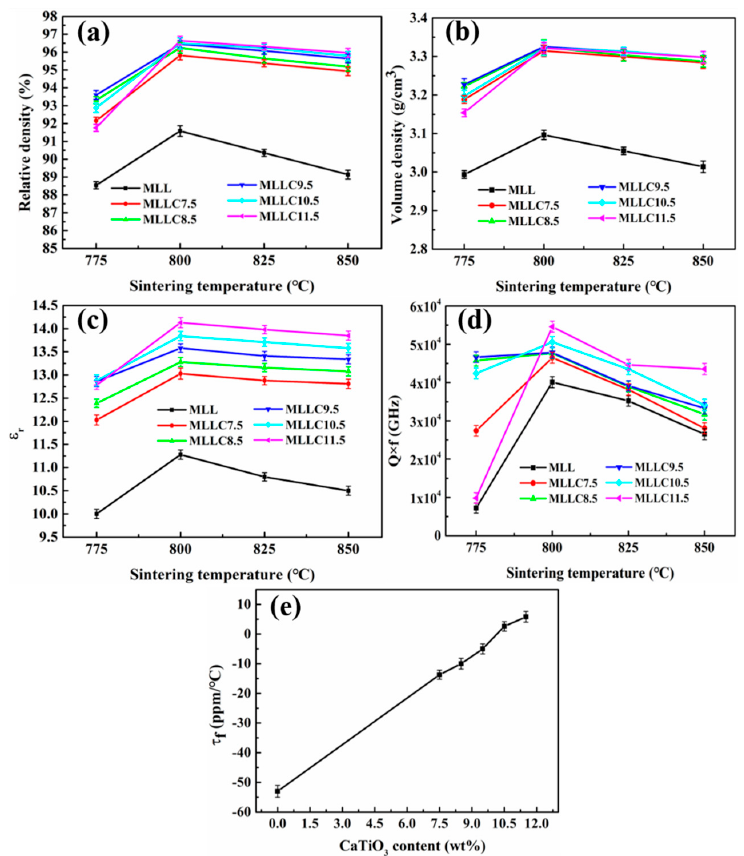
Figure 5. Relative densities, volume densities, and microwave dielectric properties of the MLLC ceramics. ( a ) Relative densities, ( b ) volume densities, ( c ) dielectric constants, ( d ) Q × f s, and ( e ) τ f s of all the samples sintered at 800 °C.